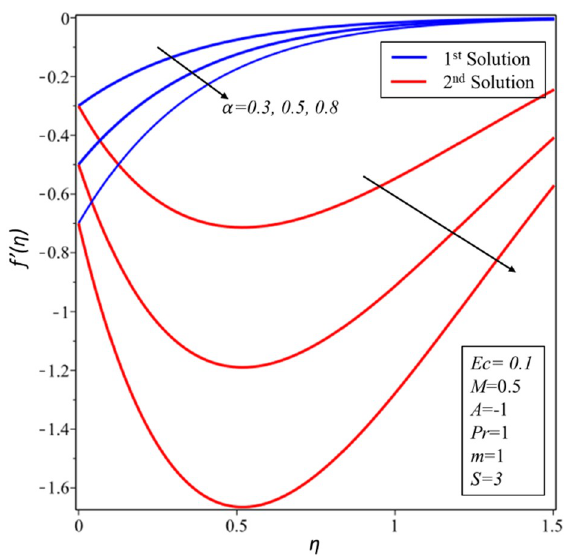
Figure 9. ′(η) for increasing values of α. Figure 9. f (cid:48) ( η ) for increasing values of α